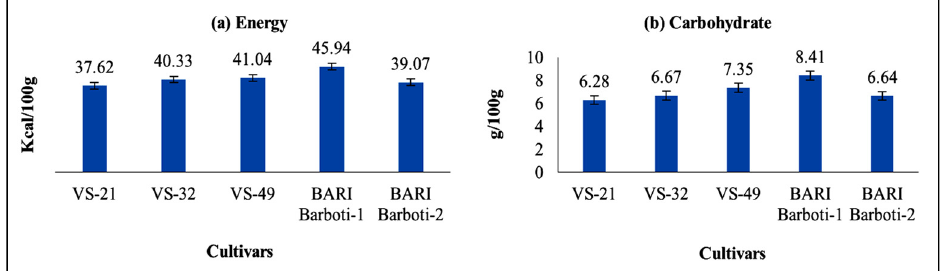
Figure 3. ( a ): energy and ( b ): carbohydrate content of five yard-long bean cultivars commonly grown in Bangladesh. Note: The parameters were estimated from 100 g of dry matter.